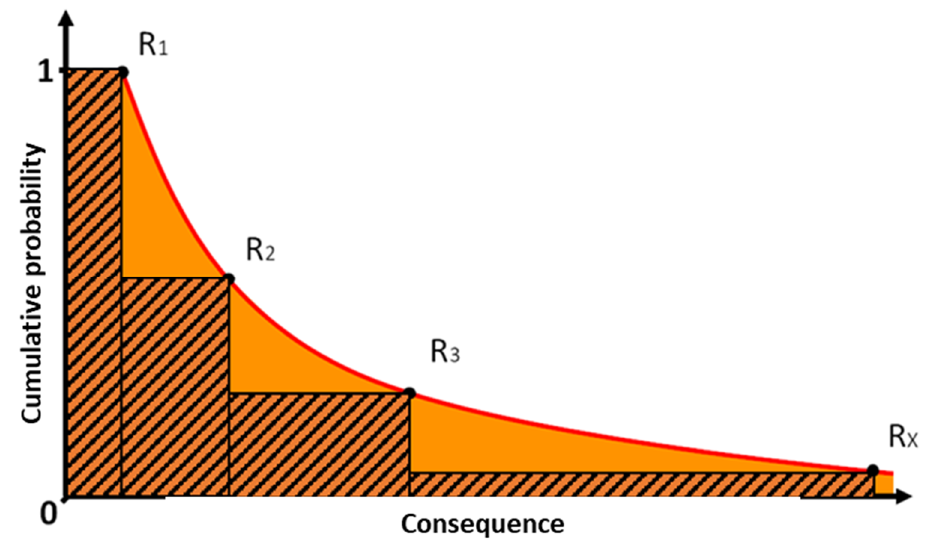
Figure 2. Conceptual graph for calculating a system’s total risk (orange area), in a probability consequence diagram, similar to the findings of Ale, Burnap, and Slater [17]. R 1 represent the baseline risk, i.e., an event that is expected to occur on regular basis, whereas R x represents the most severe event. The black striped area represents the events’ calculated total risk.